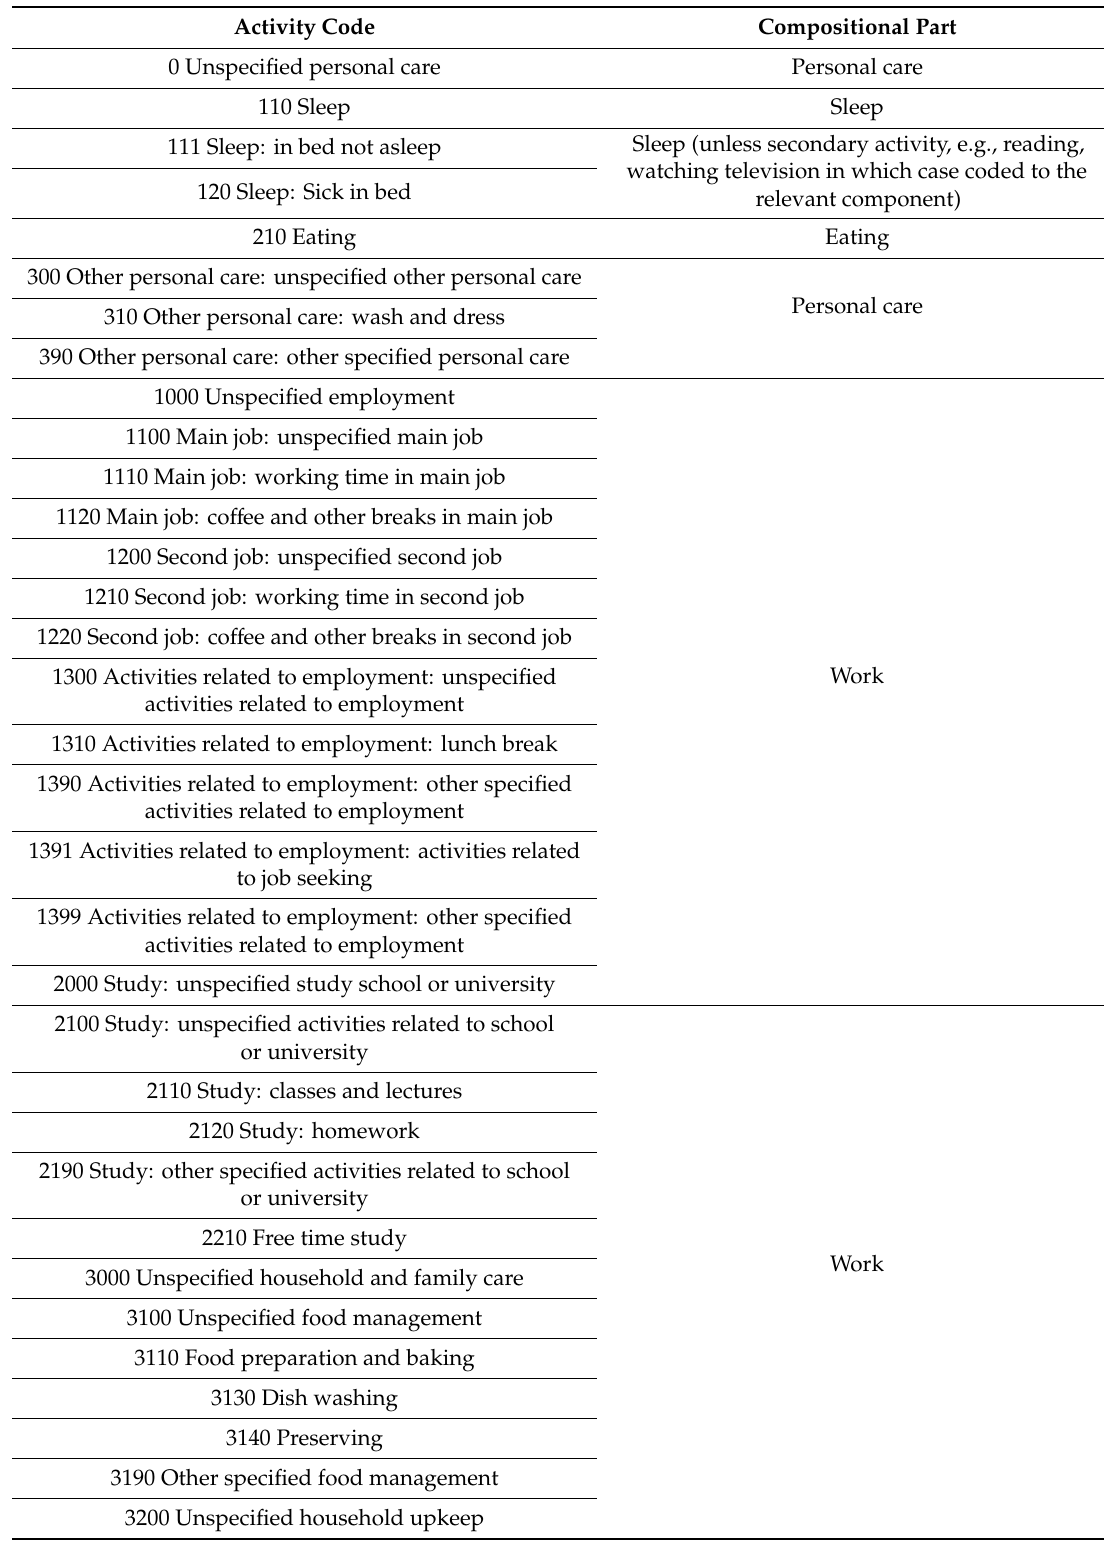
Table A1. UKTUS activity codes attributed to compositional